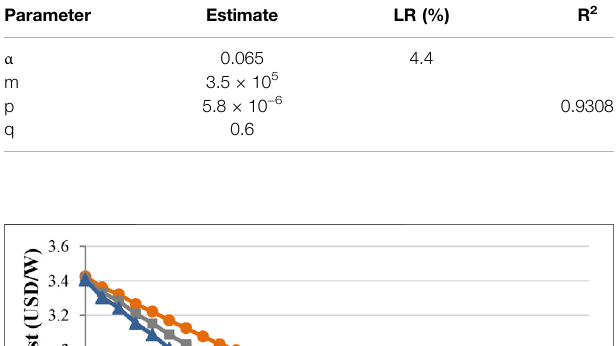
TABLE 2 | Parameter estimation of the learning curve model and innovation diffusion model. Parameter